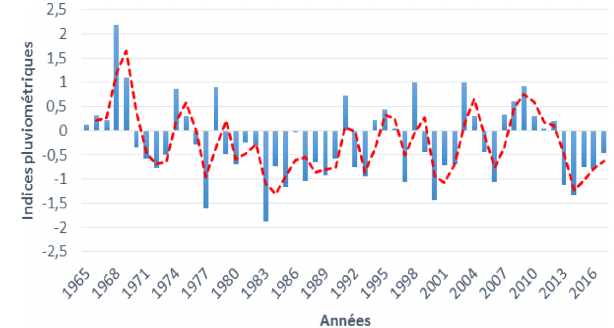
Figure 2. Indices pluviométriques au cours de la période 1965– 2017 dans le bassin Béninois de la Pendjari à l’exutoire de Porga. Sources : Météo-Bénin, et traitement des données, 2020.